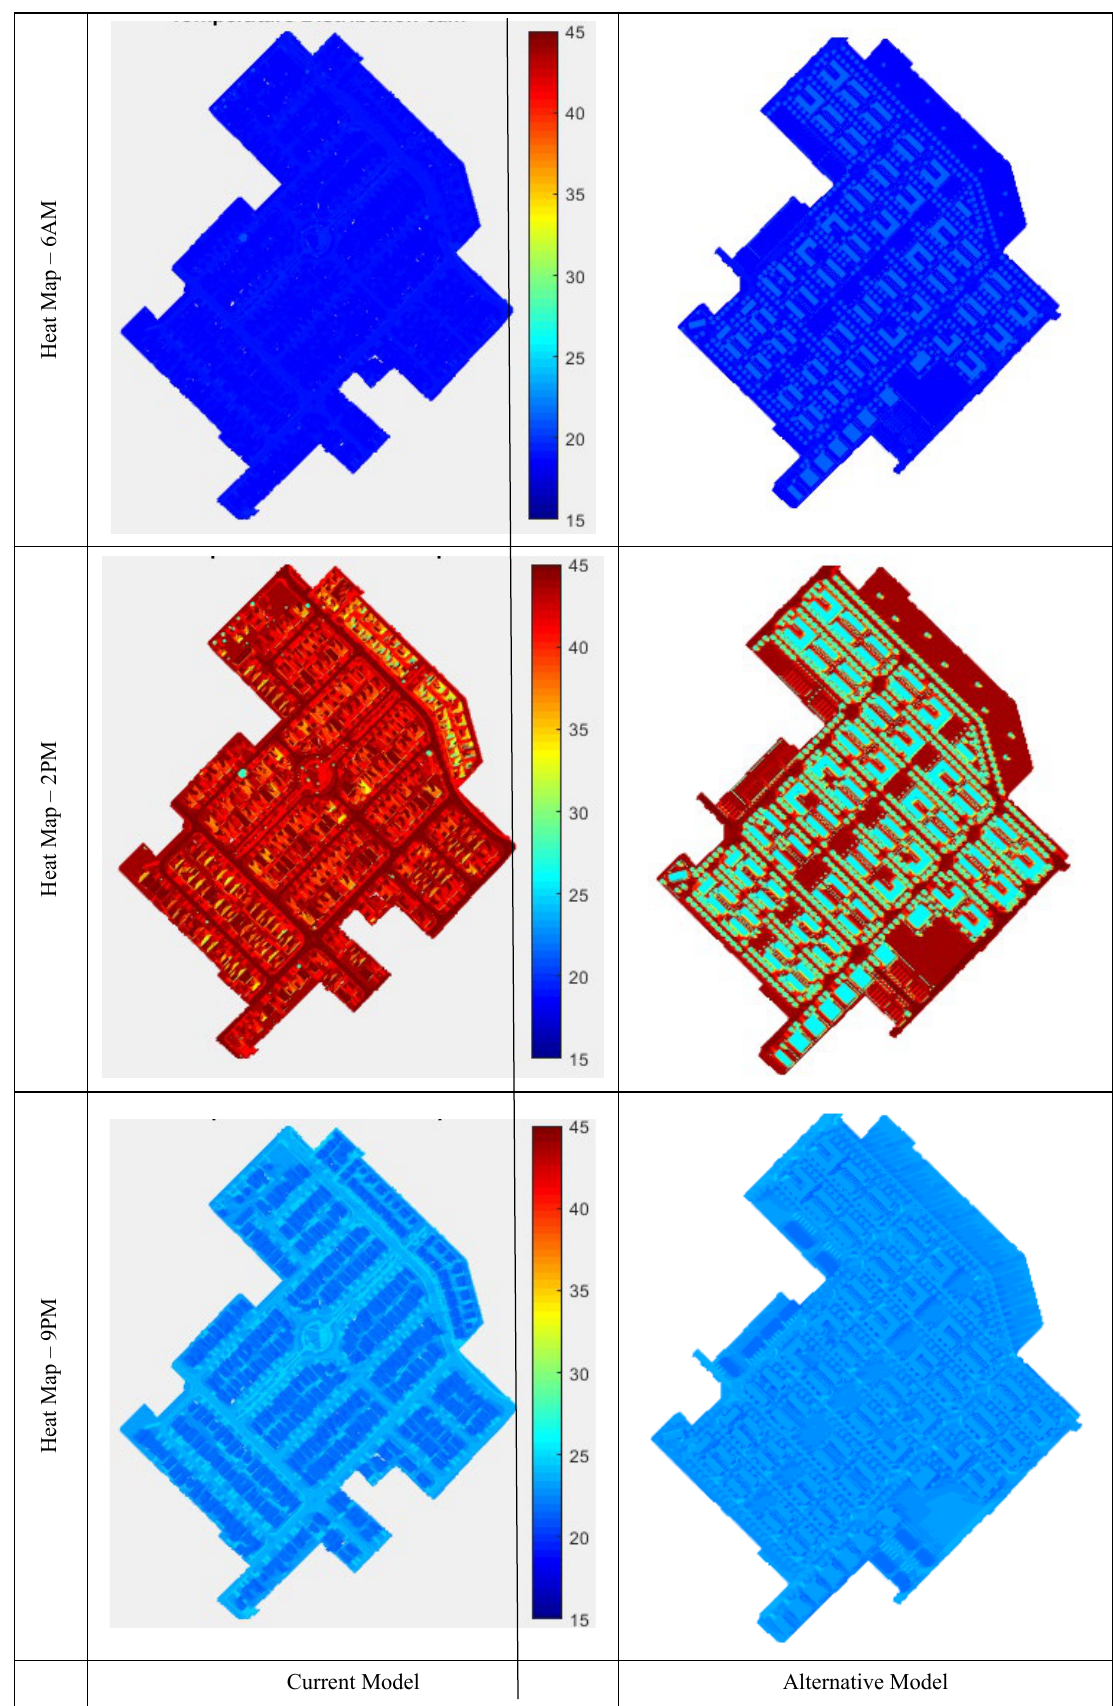
Figure 4: Results of the heat simulation of the current (left) and alternative (right)